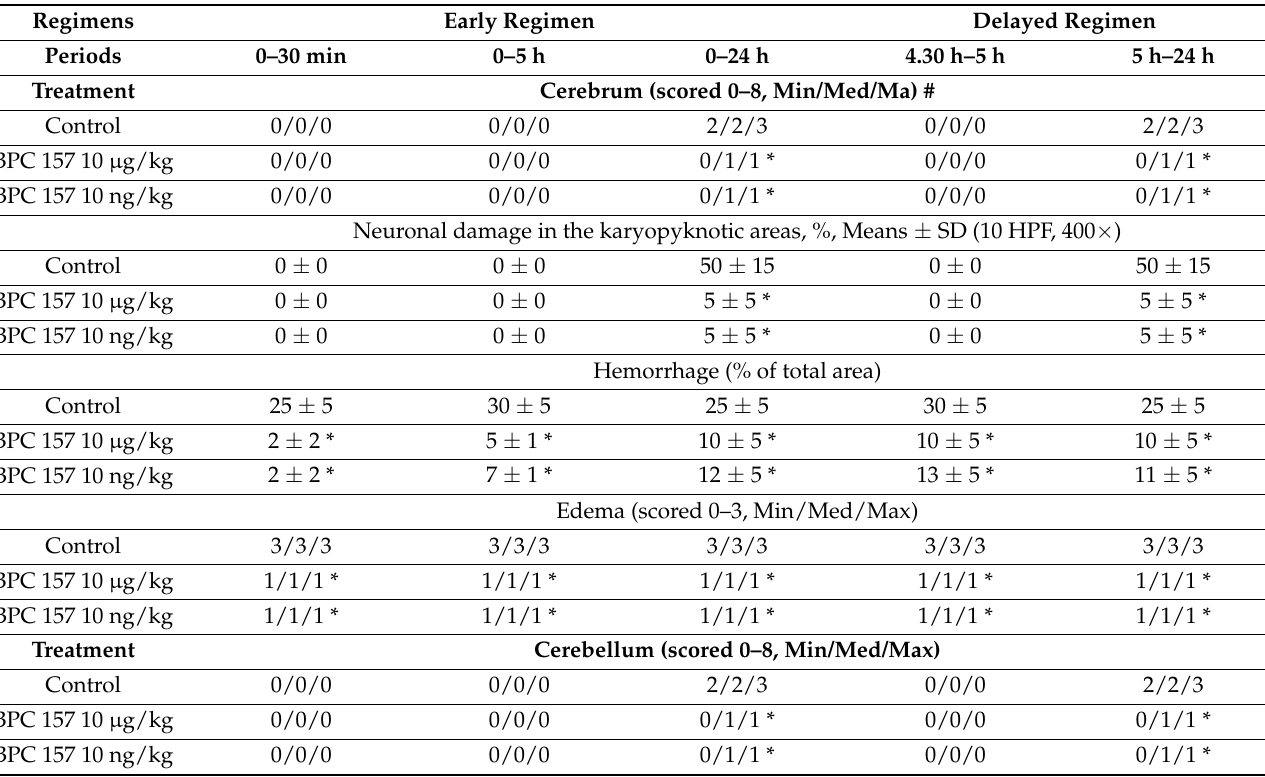
Table 2. Brain lesion assessment in the bile duct-ligated rats following ligation (time 0) at sequential periods (application sacrifice) to illustrate the effect of both early treatment and delayed treatment following ligation. * p < 0.05, at least, vs.